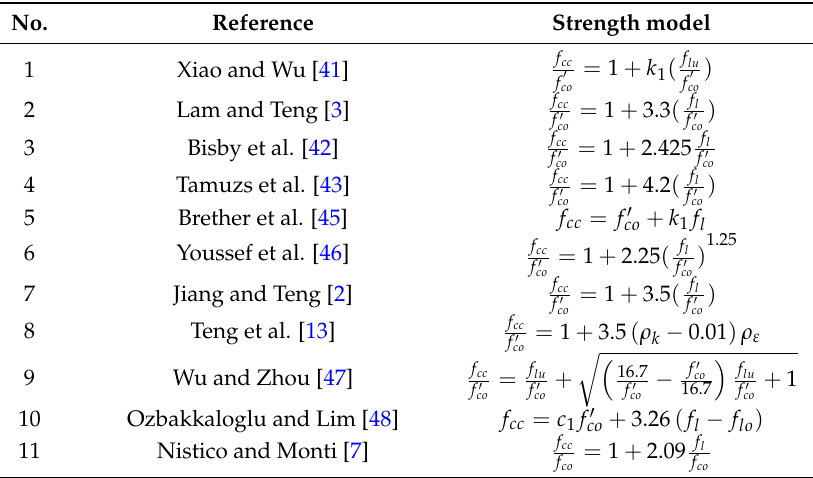
Table 7. Eleven representative ultimate strength models.